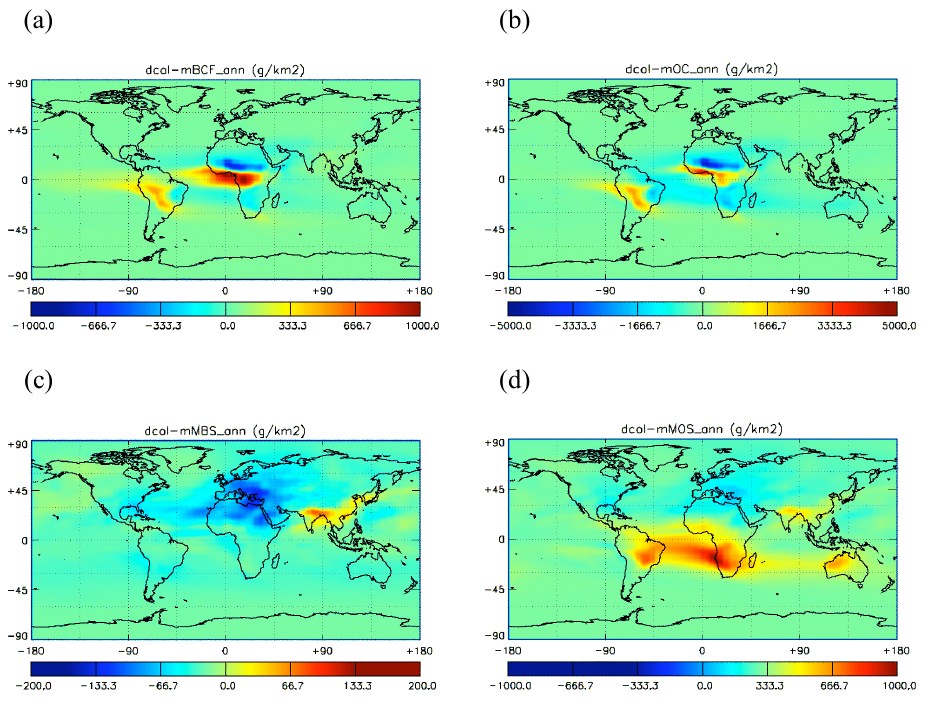
Fig. 3. Global distributions of differences in annual column loading (g/km 2 ) due to seasonal BBCA emissions in online run of: (a) BC, (b) OC, (c) BC-sulfate mixture (MBS), and (d) OC-sulfate mixture (MOS).